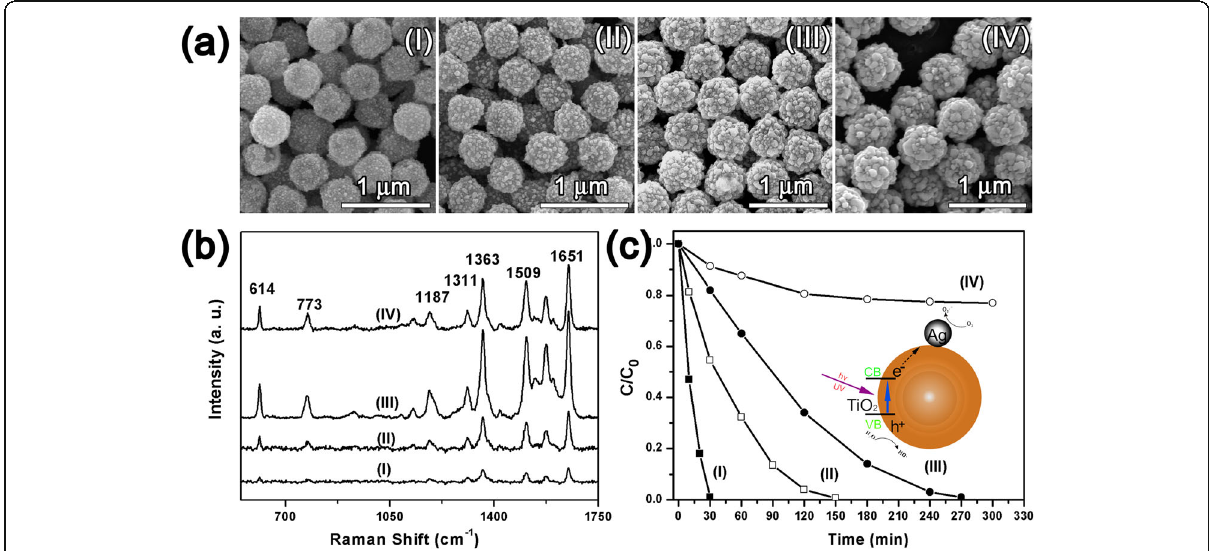
Fig. 5 The SEM images of ( a , b ) typical magnetic-assembled film and ( c , d ) typical self-assembled film and their SERS signals reproducibility ( e ) and ( f ), respectively. The intensity distribution of peak at 1363 cm -1 from magnetic-assembled film and self-assembled film ( g ) and concentration- dependent SERS spectra of magnetic-assembled film ( h